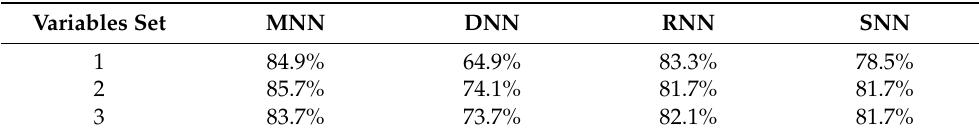
Table 9. Accuracy of the used models for testing data.